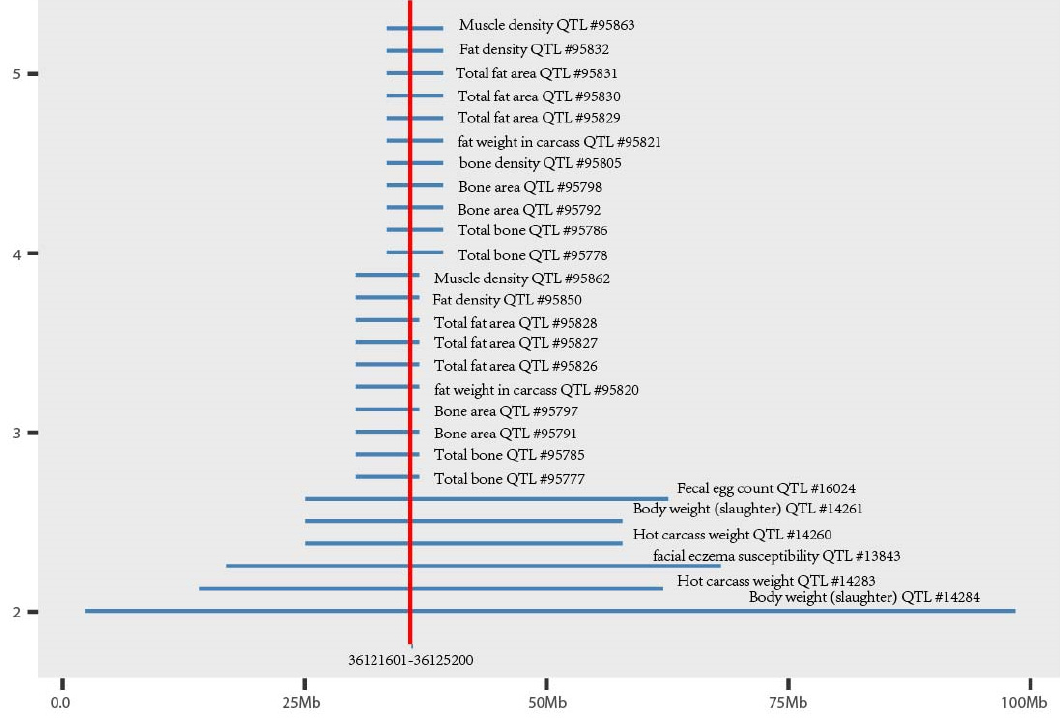
Figure 3. The CNV region of the PIGY gene overlaps with the quantitative trait loci (QTL) of the sheep.